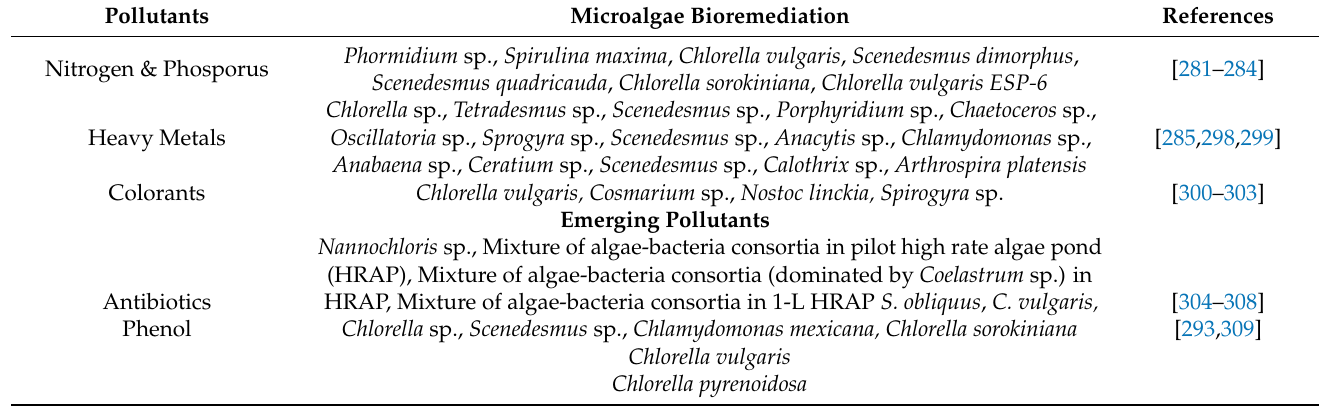
Table 9. Microalgae used in the remediation of the pollutants present in the wastewater.